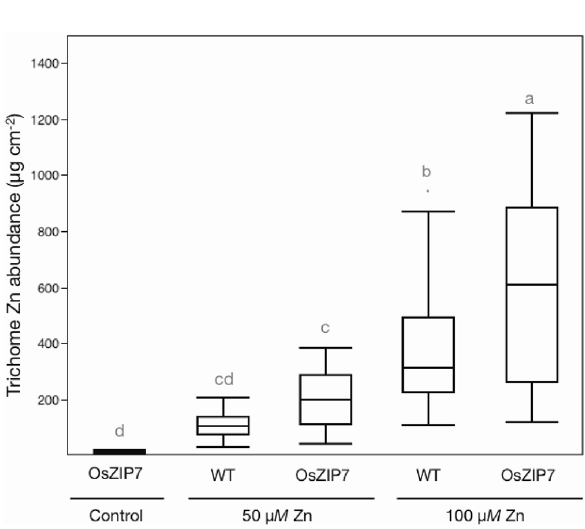
Figure 2. Total Zn abundance in individual trichomes. Total Zn per trichome was estimated using Region of Interest (ROI) analyses. All trichomes in each leaf showing Zn accumulation in the maps were included in the analyses (n = 30–32). Significant differences detected by one-way ANOVA and Tukey HSD are represented by different lower case letters above the